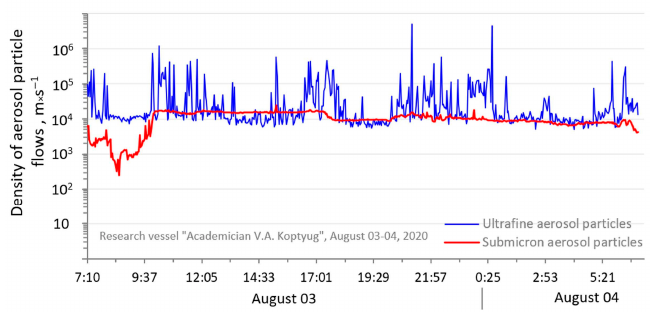
Figure 8. Temporal variability of density of aerosol particle flows on the surface of Middle Baikal, 3–4 August 2020.